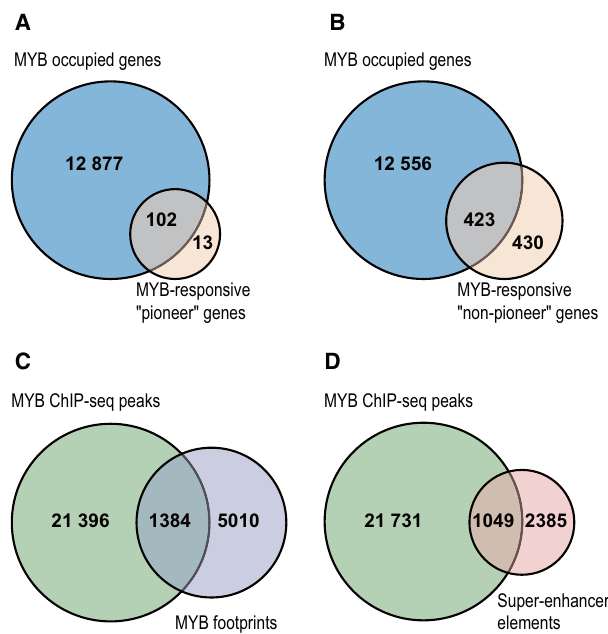
Figure 7. Proportion of direct and indirect MYB target genes. ( A ) Intersection between MYB occupied genes and MYB’s pioneer target genes. ( B ) Intersection between MYB occupied genes and MYB’s non-pioneer target genes. The pioneer and non-pioneer target genes were identified from our previous RNA-seq data in K562 (GEO accession: GSE85187), where an endogenous MYB KD affected genes were rescued by a WT MYB but not a pioneering function deficient D152V mutant MYB, hence corresponding to MYB responsive pioneer target genes. In contrary, the non-pioneer target genes correspond to those target genes whose MYB KD related phenotype was rescued by both WT and D152V MYB. ( C ) Intersection between MYB ChIP-seq peaks and MYB’s digital footprints in K562. Computationally predicted digital footprints of MYB previously reported in our lab 39 was used to investigate genomic overlap with the current MYB ChIP-seq peaks. ( D ) Intersection between MYB ChIP-seq peaks and MYB super-enhancer elements in K562. Super-enhancer elements in K562 reported in Qian et al. was used to investigate the overlap with the current MYB ChIP-seq peaks 58 . The genomic Overlaps between MYB occupied regions and that of MYB DGF or K562 SEs were investigated using bedtools v2.17.0 74 . Example UCSC tracks illustrating each of the overlapping and non-overlapping condition for panel (A-D) are provided in Supplementary Figure